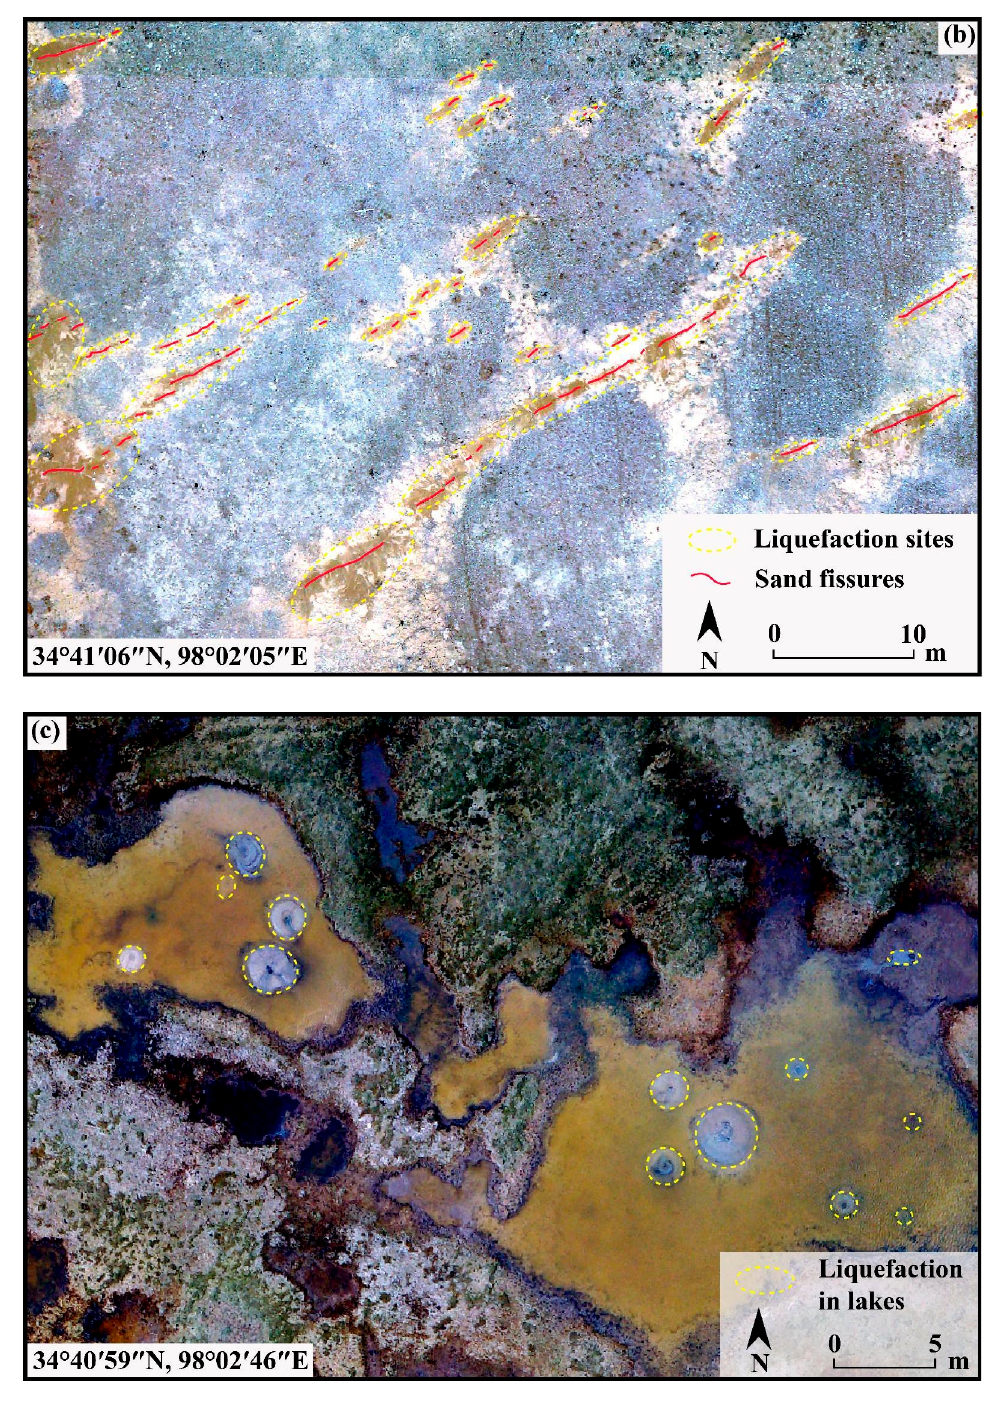
Figure 3. Some examples of soil liquefaction phenomena interpretation based on high-resolution DOMs.